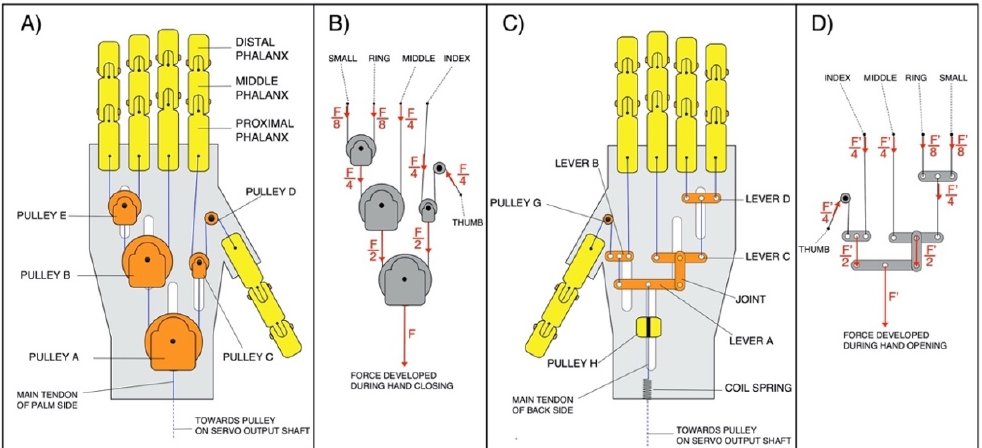
Figure 2. Illustration of the “Federica” hand design: ( A ) Palm side of the mechanical system; ( B ) force distribution on its palm side during closing; ( C ) the back side of the mechanical system; ( D ) force distribution on back side during opening. The mechanical system is equipped with two main tendons: one actuator (palm side) and one antagonist (back side) to perform, respectively, the closing (fingers flexion) and